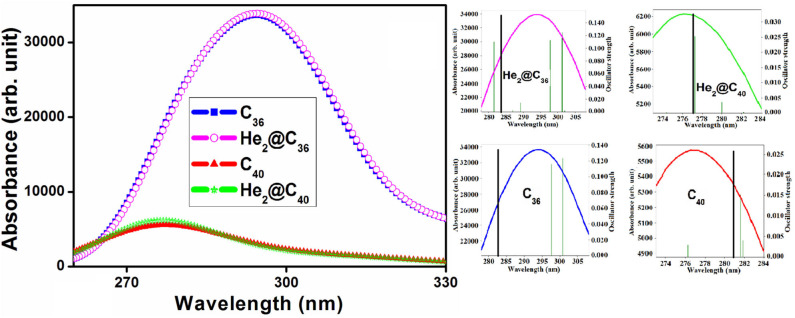
UV-visible absorption spectra of CX and He2@CX (X = 36, 40).